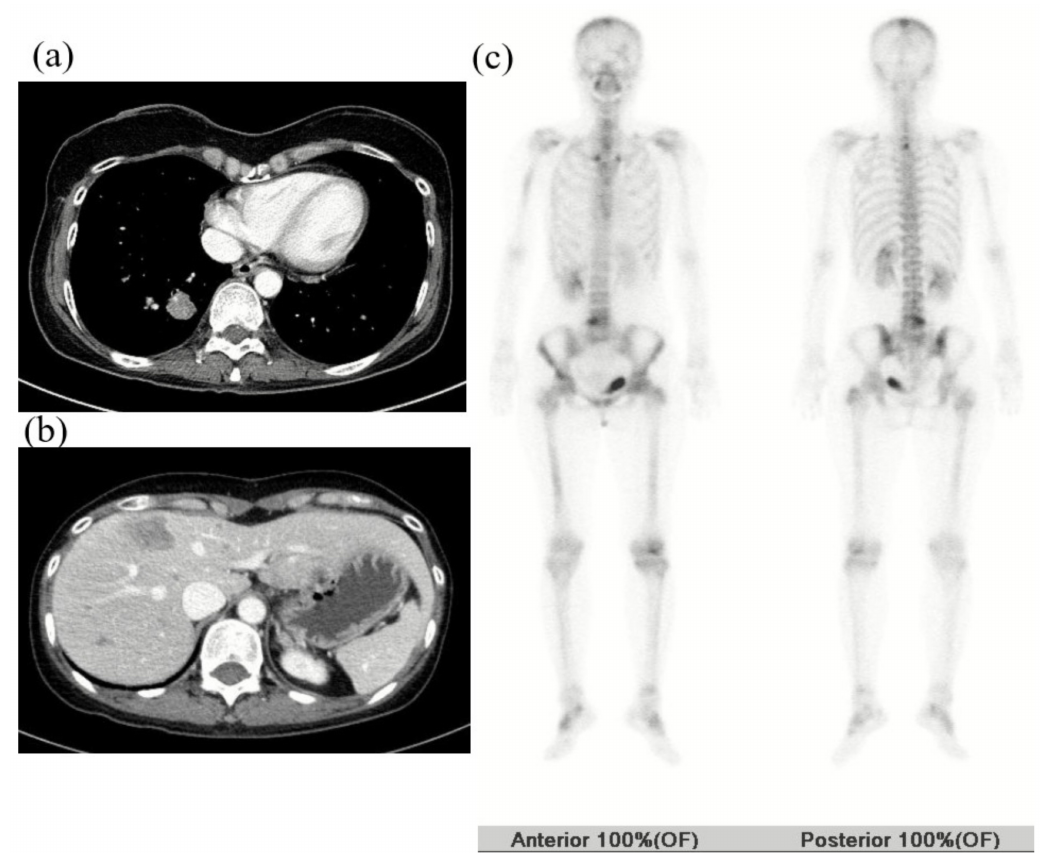
Figure 3. Imaging of patient No. 1 at the first recurrence of breast cancer in September 2018. ( a , b ) Computed tomography (CT) scan of the chest and abdomen showed a metastatic mass in the right lower lobe of the lung and multiple hepatic masses. ( c ) Body bone scan revealed multiple metastatic bone lesions (left frontal bone, thoracic spine, right humeral shaft, and left proximal femur).